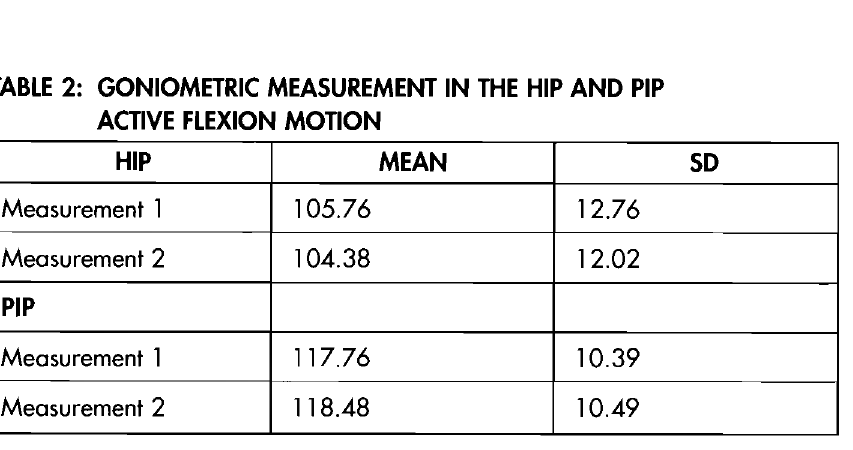
TABLE 2: GONIOMETRIC MEASUREMENT IN THE HIP AND